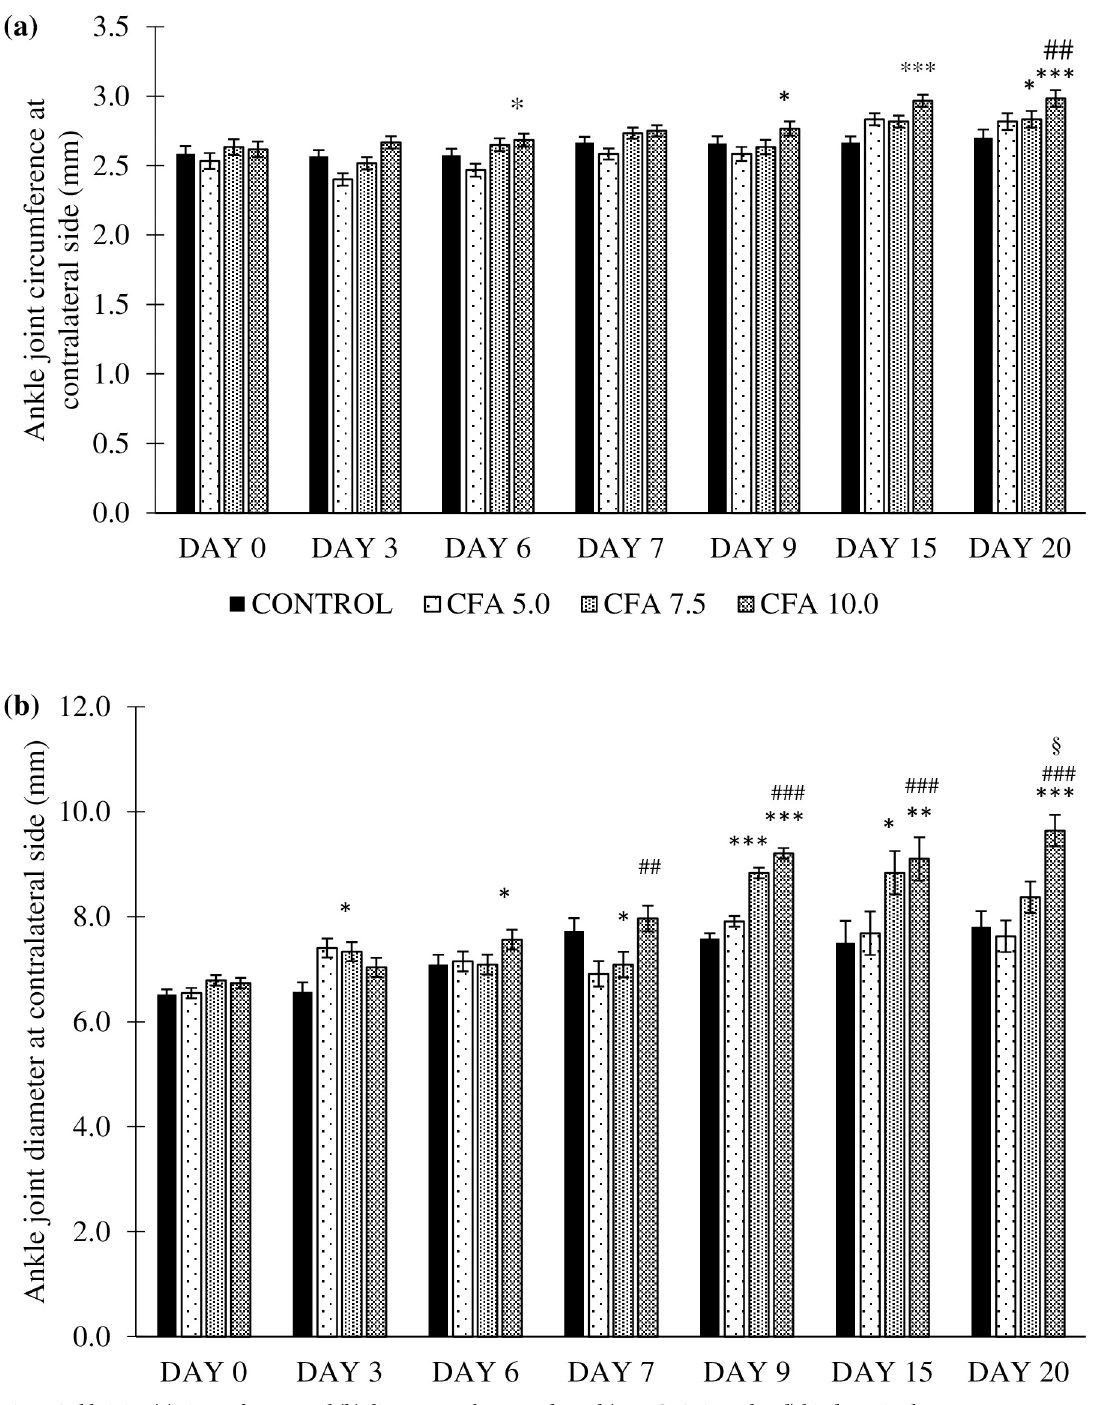
Fig 7. Ankle joint (a) circumference and (b) diameter at the contralateral (non-CFA- inoculated) hind paw in the treatment groups (n = 6). The values are presented as mean ± standard error of mean (SEM). � p < 0.05, �� p < 0.01 and ��� p < 0.001 significant comparison to control group. # p < 0.05, ## p < 0.01 and ### p < 0.001 significant comparison to CFA 5.0 group. CFA 10.0 group showed a constant increase of inflammatory oedema at the contralateral (non-injected hind paw), indicating the development of chronic polyarthritis following CFA